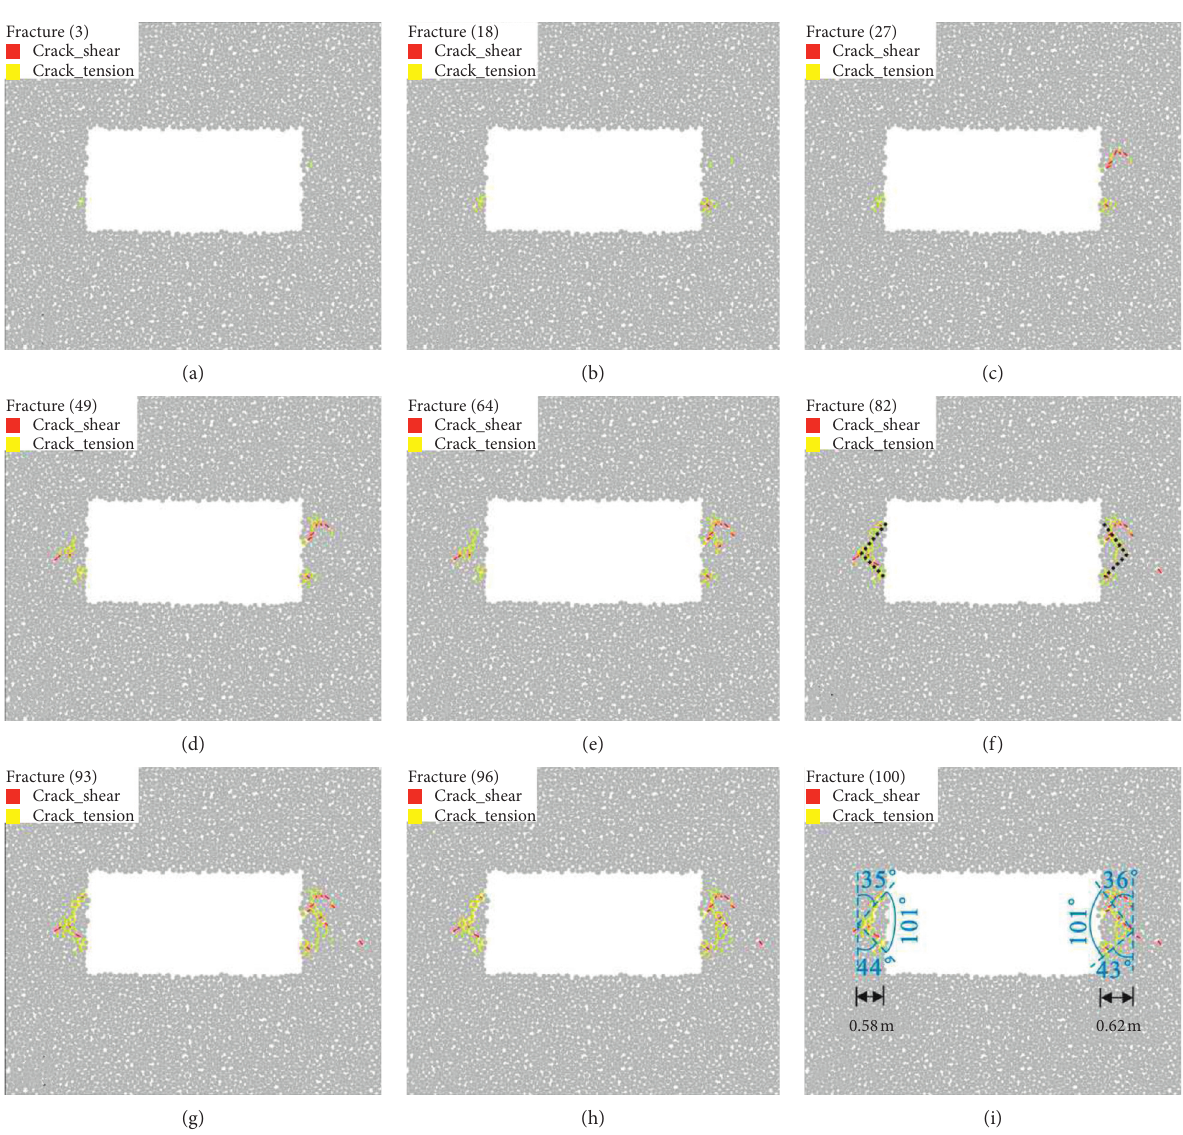
Figure 14: Evolution of damage and microcracks within the coal roadway-surrounding rock at simulation time-steps. (a) 500, (b) 1000, (c) 1300, (d) 1500, (e) 1800, (f) 2000, (g) 2500, (h) 3000, and (i)